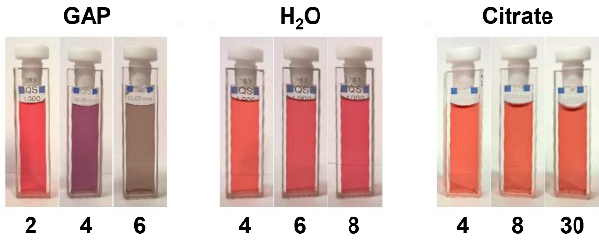
Figure 4. Change of color of the different AuNPs preparations with time. Timescale in days. Table 1. Dimensions of the nanowires after stopping the AuNPs aggregation and fusion at di ff erent times and the maximum of the longer-wavelength plasmon resonance